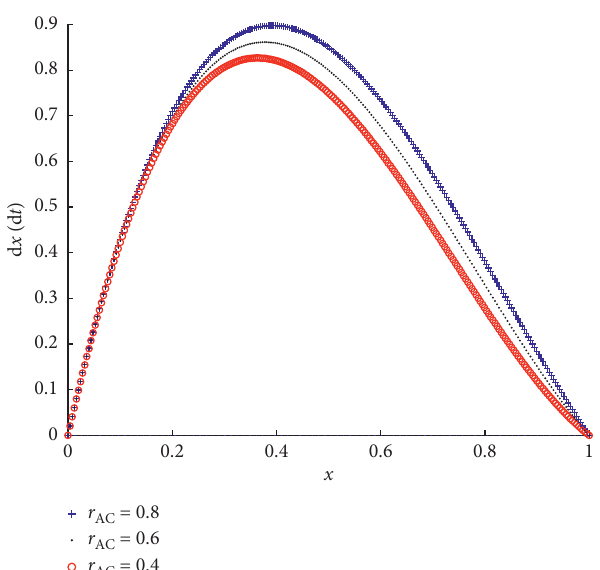
Figure 3: Simulation test results.